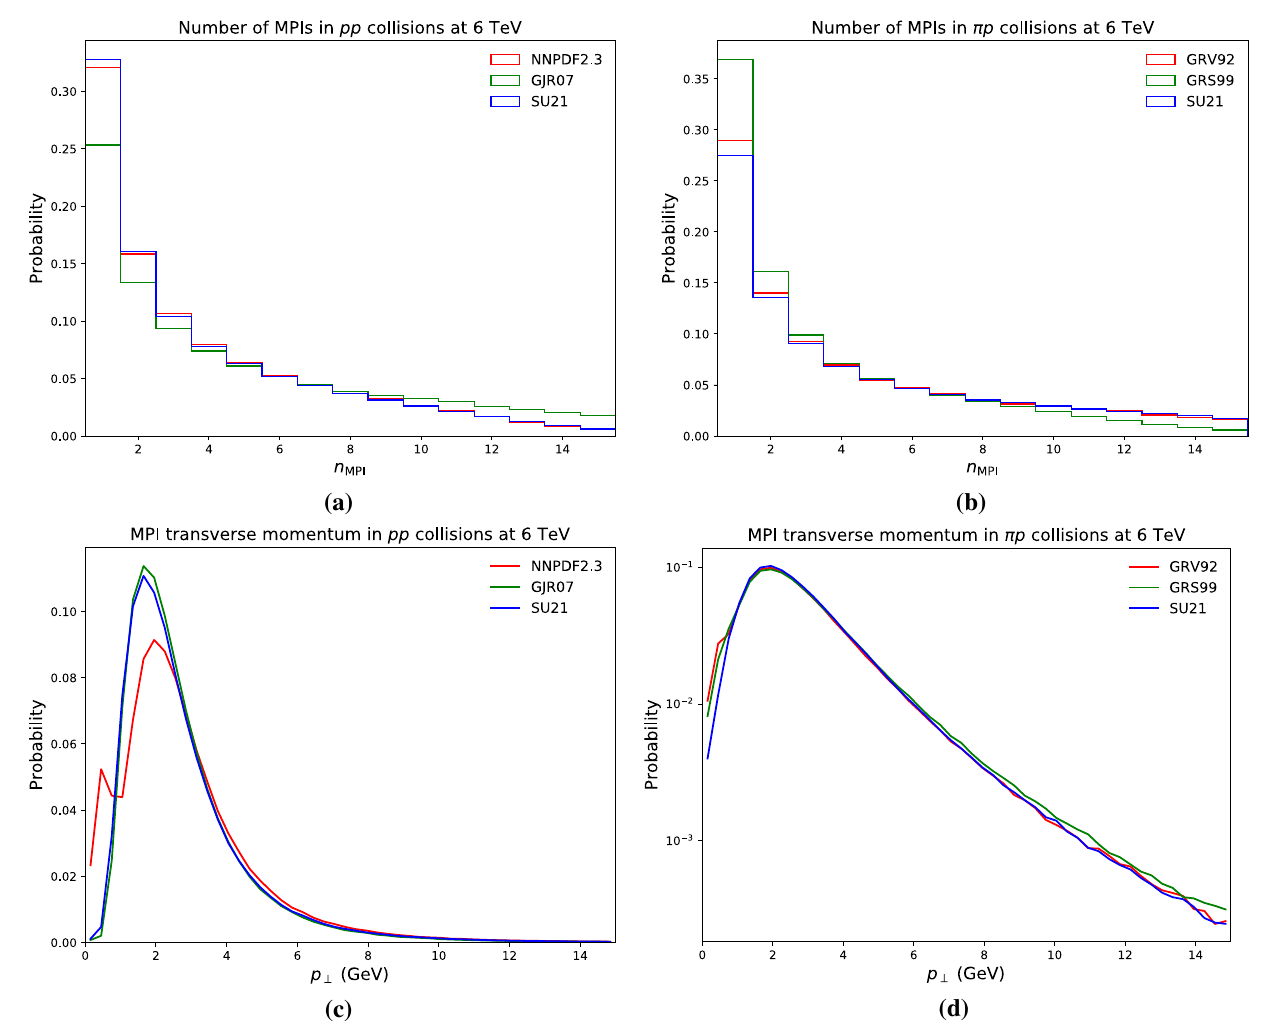
Fig. 3 The a , b number and c , d transverse momentum spectrum of MPIs, for a , c protons and b , d pions. Each PDF has a cutoff and is considered constant below some Q 0 , which leads to the bumps at low p ⊥ , especially noticeable for NNPDF2.3 distribution in c , whose cutoff is Q = 0 . 5 GeV